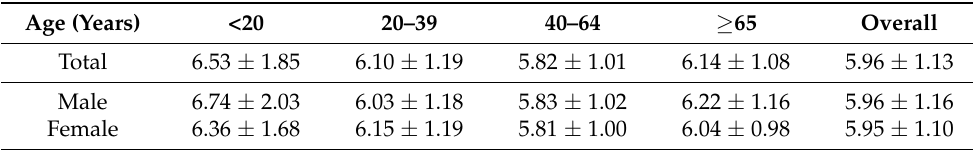
Table 2. Average sleep duration (h) by age